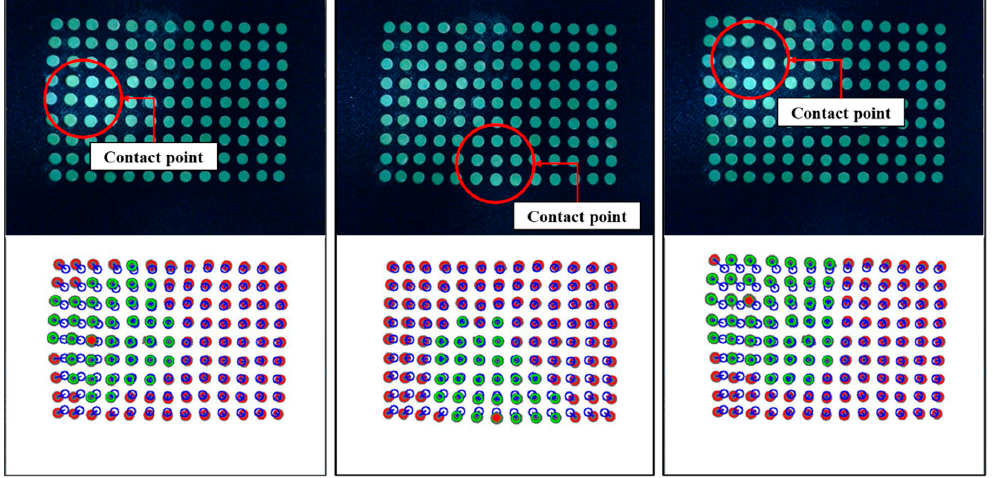
Figure 11. Maximum depth value marker tracking results using polynomial fitting algorithm.